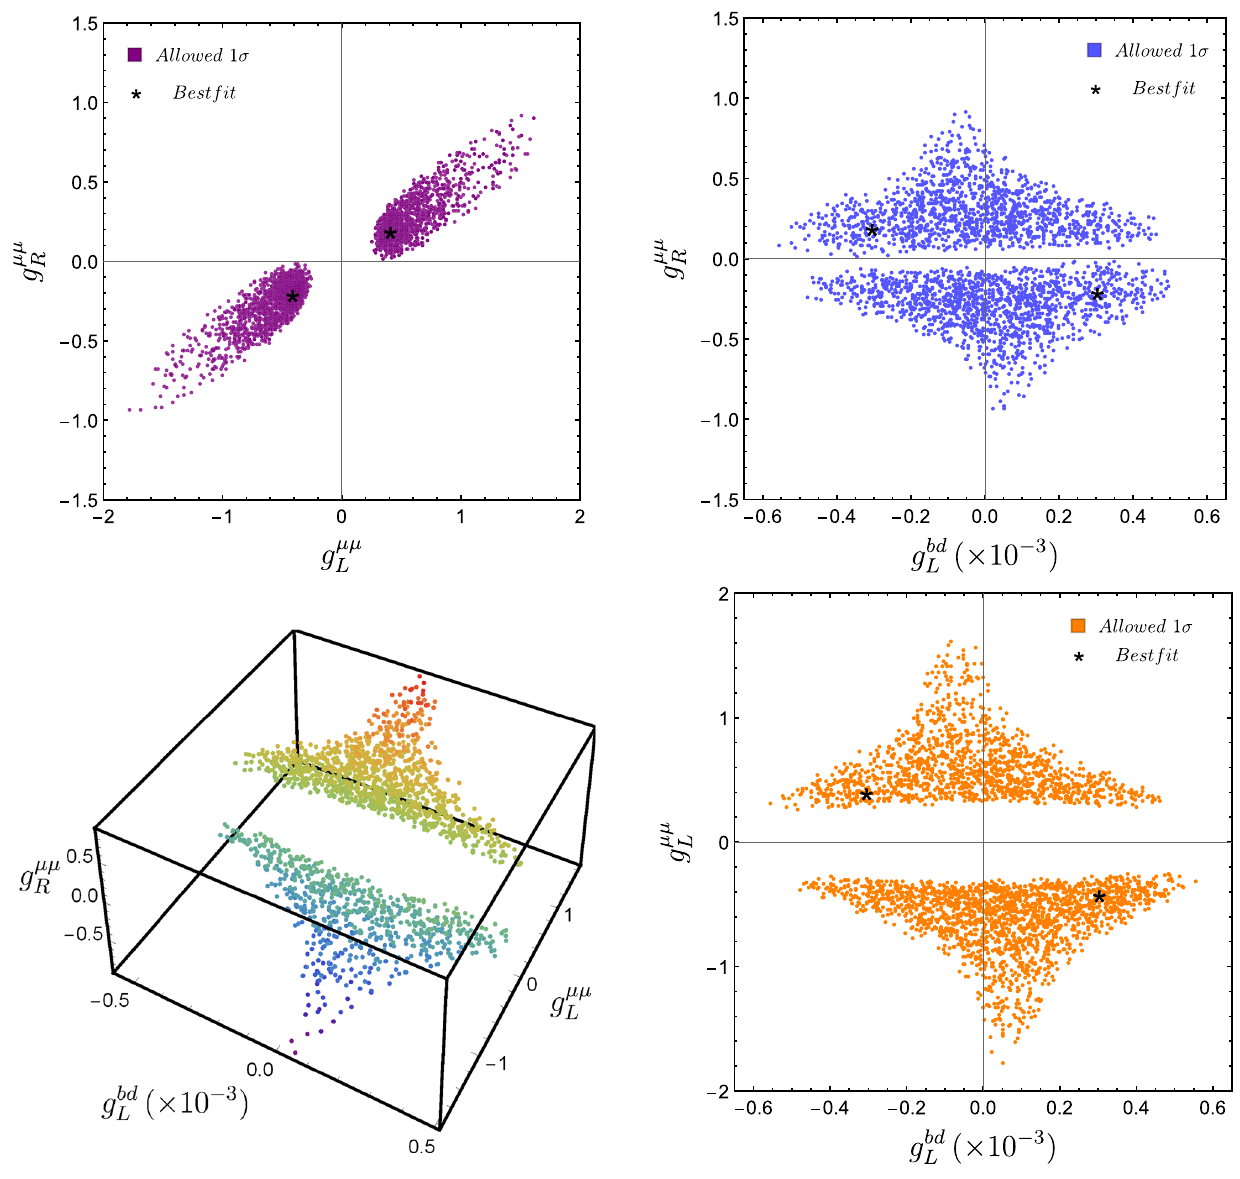
μμ μμ Fig. 2 The 1 σ -favored ( g bd , g , g ) parameter space for a Z (cid:3) model with real couplings, for M Z (cid:3) = 1 TeV. The colors red to blue in the bottom L R L μμ left 3D parameter space correspond to decreasing values of g R Table 1 Values of NP Wilson coefficients for benchmark scenarios mum deviation from the SM predictions of the observables considered. NP1, NP2 corresponding to a Z (cid:3) model with real couplings, and sce- Thelasttwoscenarios,forcomplexcouplings,arethe1 σ -favouredones narios NP3, NP4 with complex couplings. The first two benchmark ] and a near-minimum value with a near-maximum value of Im[ C bd , NP 9 scenarios NP1 and NP2 for real Z (cid:3) couplings, correspond to a maxi- of Re[ C bd , NP ] 10 Scenario NP1 NP2 NP3 NP4 + 0 . C bd , NP 9